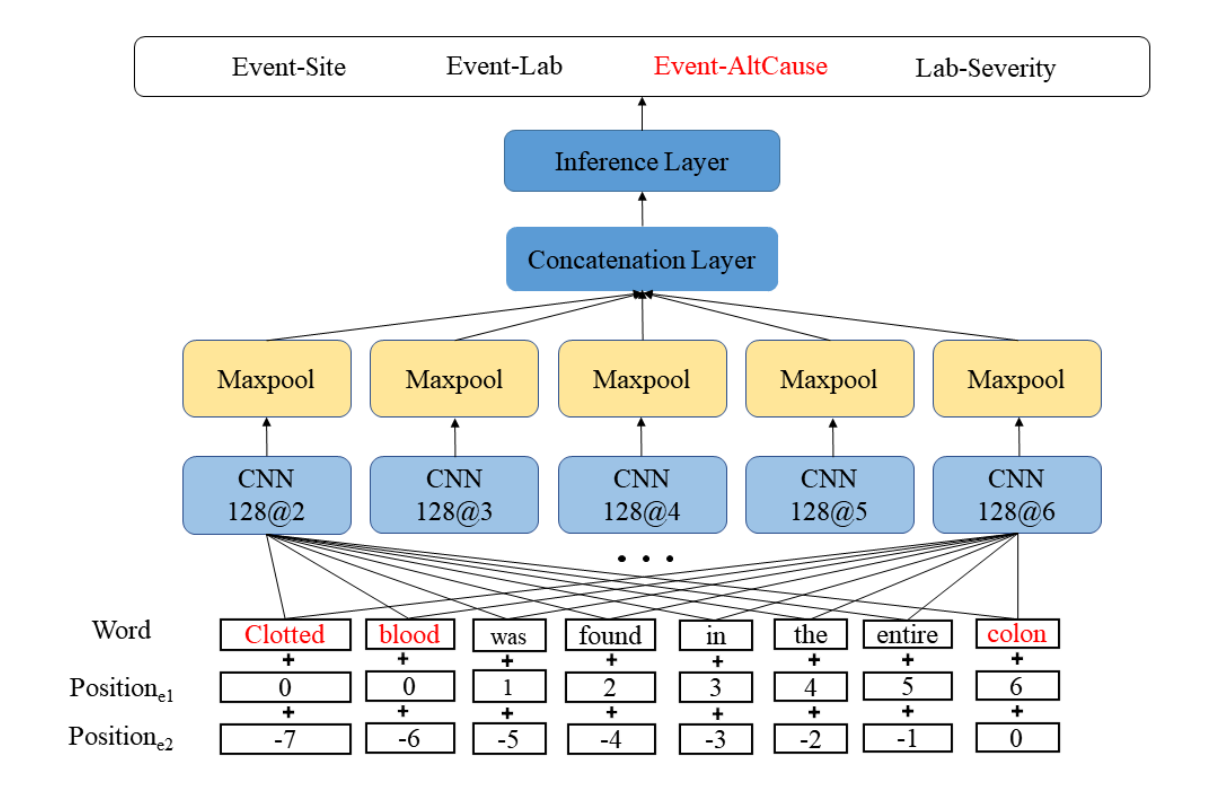
Figure 2. The high-level view of our convolutional neural network (CNN) model. It has five different CNN modules with filters of different window sizes, followed by maxpooling and concatenation. The inference layer includes a dropout, a fully connected layer, and a softmax layer. Positione1